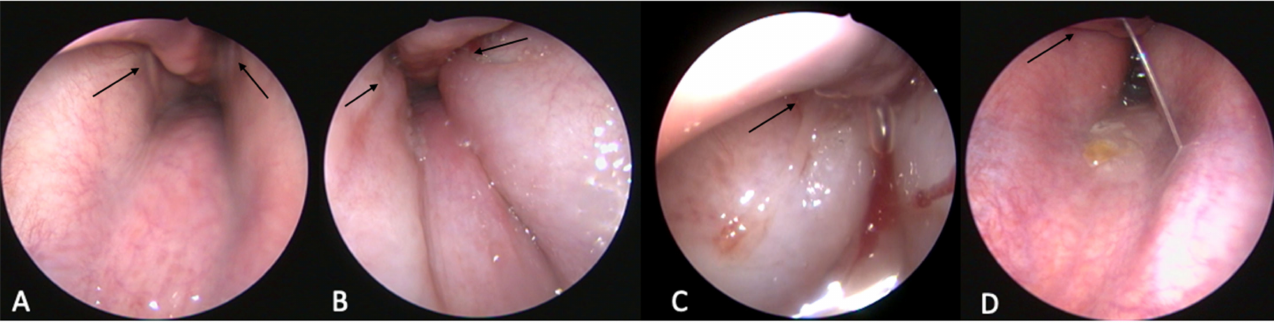
Figure 7. Endoscopic view of the nasopharynx of in vivo case 21/22. ( A ) Before HA injection; ( B ) after injecting the left tube (case 21, shown here on the right); ( C ) after bilateral injection; ( D ) on day 7. The ET orifices are marked by black